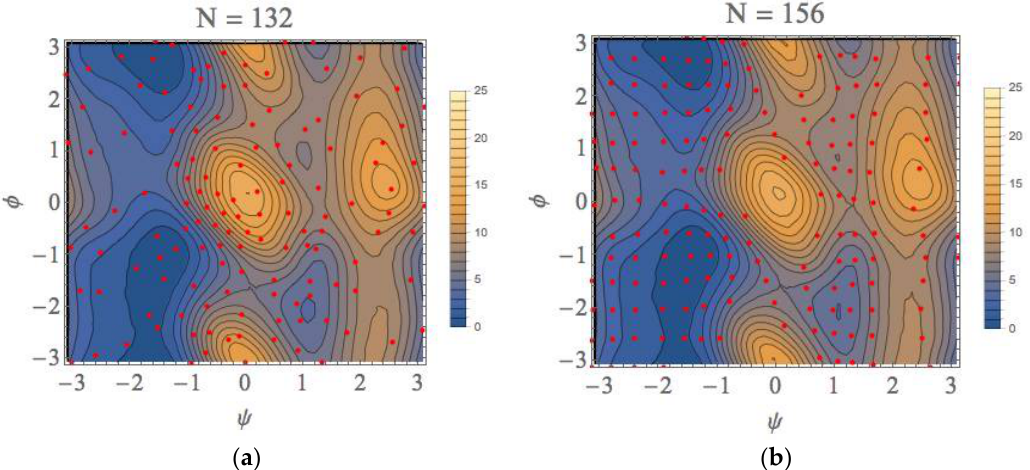
Figure 7. The free-energy landscapes of the (φ, ψ) space for the alanine dipeptide system with using ( a ) our exploration scheme and ( b ) the usual US + WHAM method. Table 1. The characteristics of all equilibrium conformations (EQ) and transition states (TS) calculated with our scheme (N = 132). The values obtained from usual US + WHAM calculations are also listed in